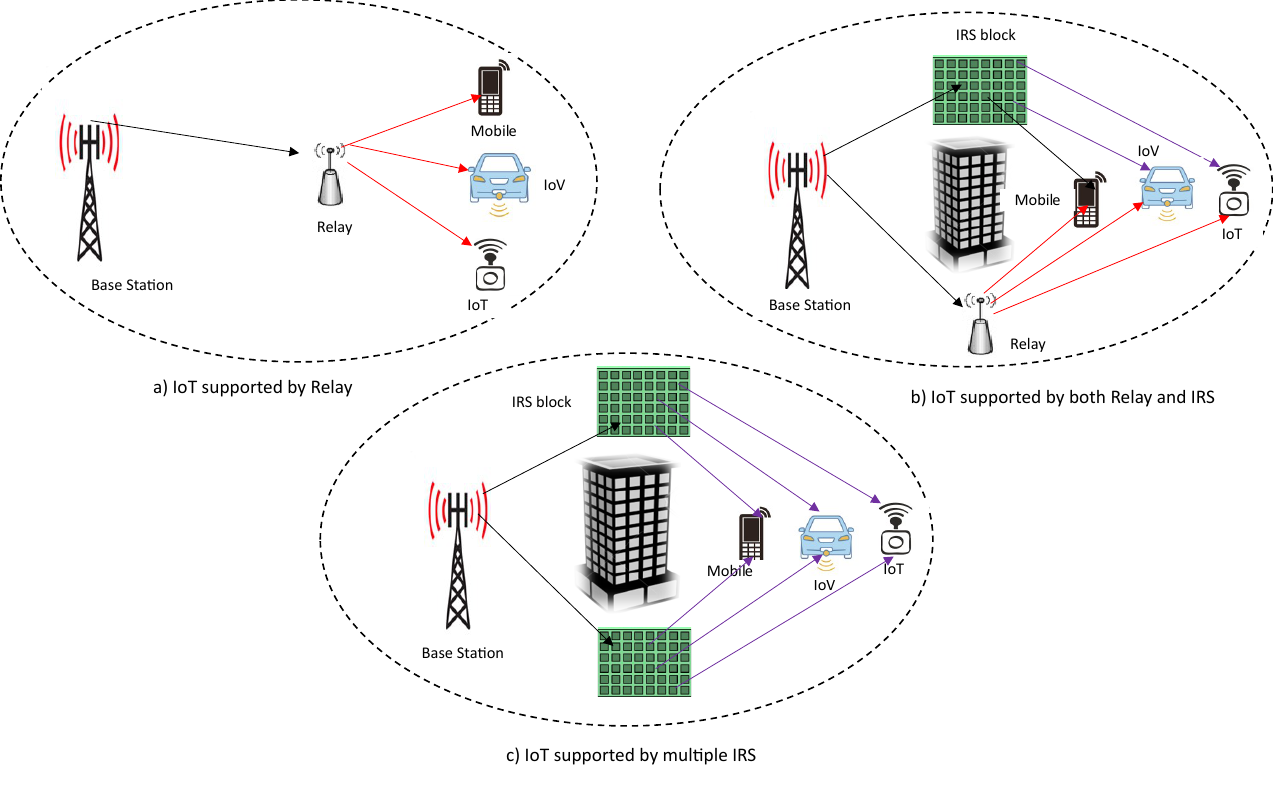
Figure 1. Relay and IRS-aided wireless IoT